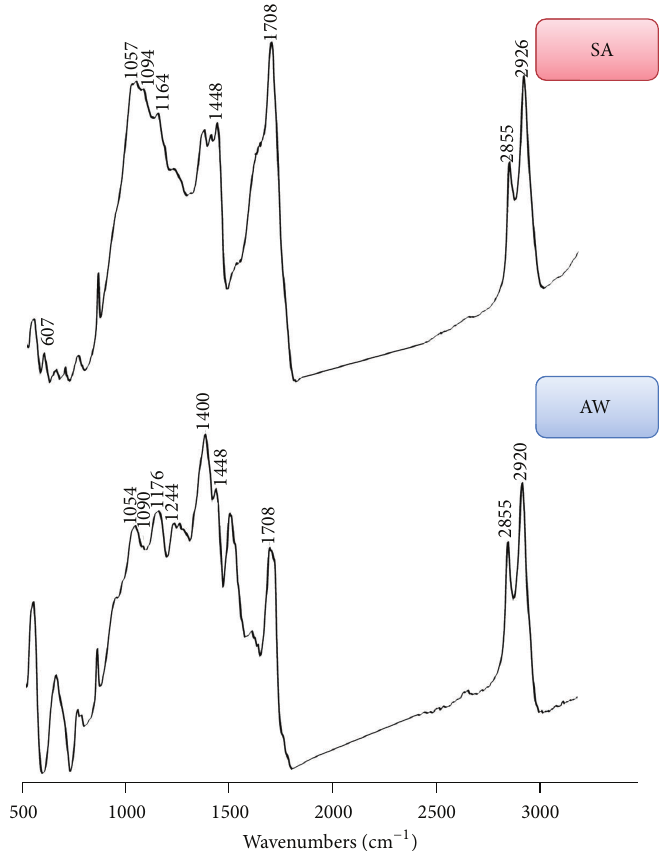
Figure 5: FT-IR spectra of sample taken from “Servilius Appius” (SA) and “Allegory of Wealth” (AW).